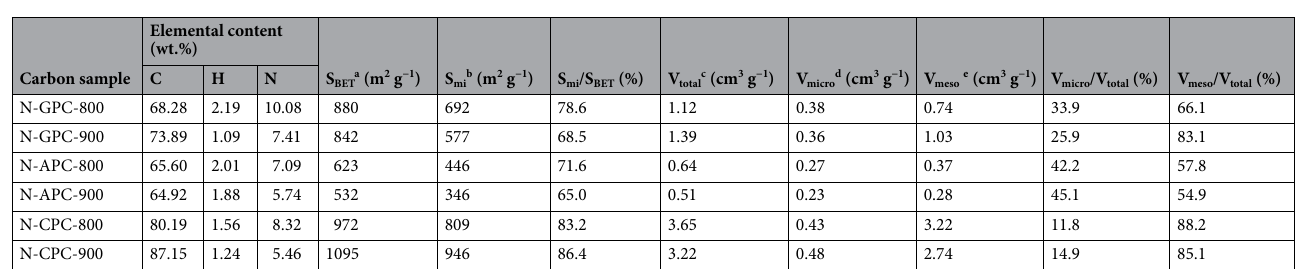
Table 1. Physicochemical properties and elemental composition via bulk combustion of carbon samples. a Specific surface areas were obtained through the Brunauer–Emmett–Teller (BET) method. b Micropore surface was area acquired by means of the t–plot method. c Total pore volume was calculated using the Density Functional Theory (DFT) method. d Micropore volume was measured using the Horvath-Kawazoe method. e Mesopore volume was calculated by subtracting V micro from V total